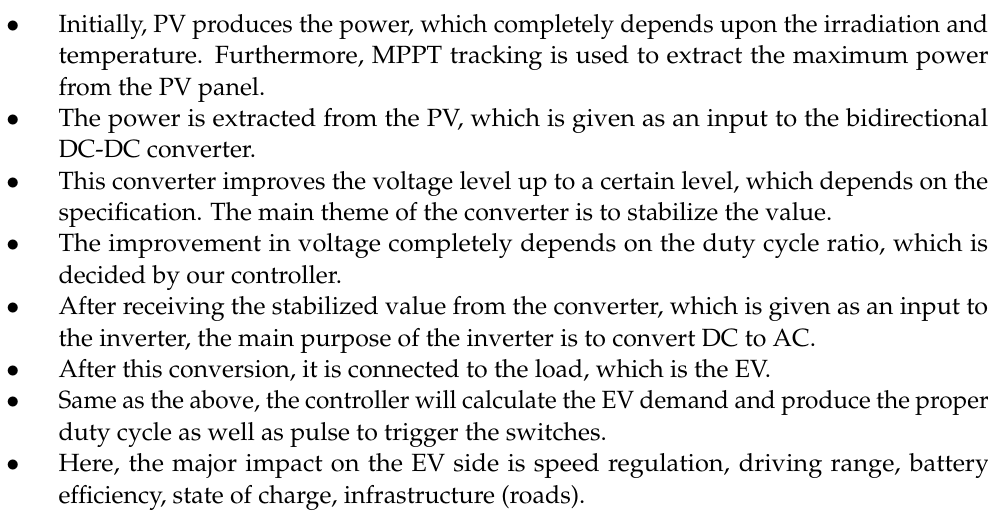
Figure 4. Process of PV-to-Electric Vehicle.